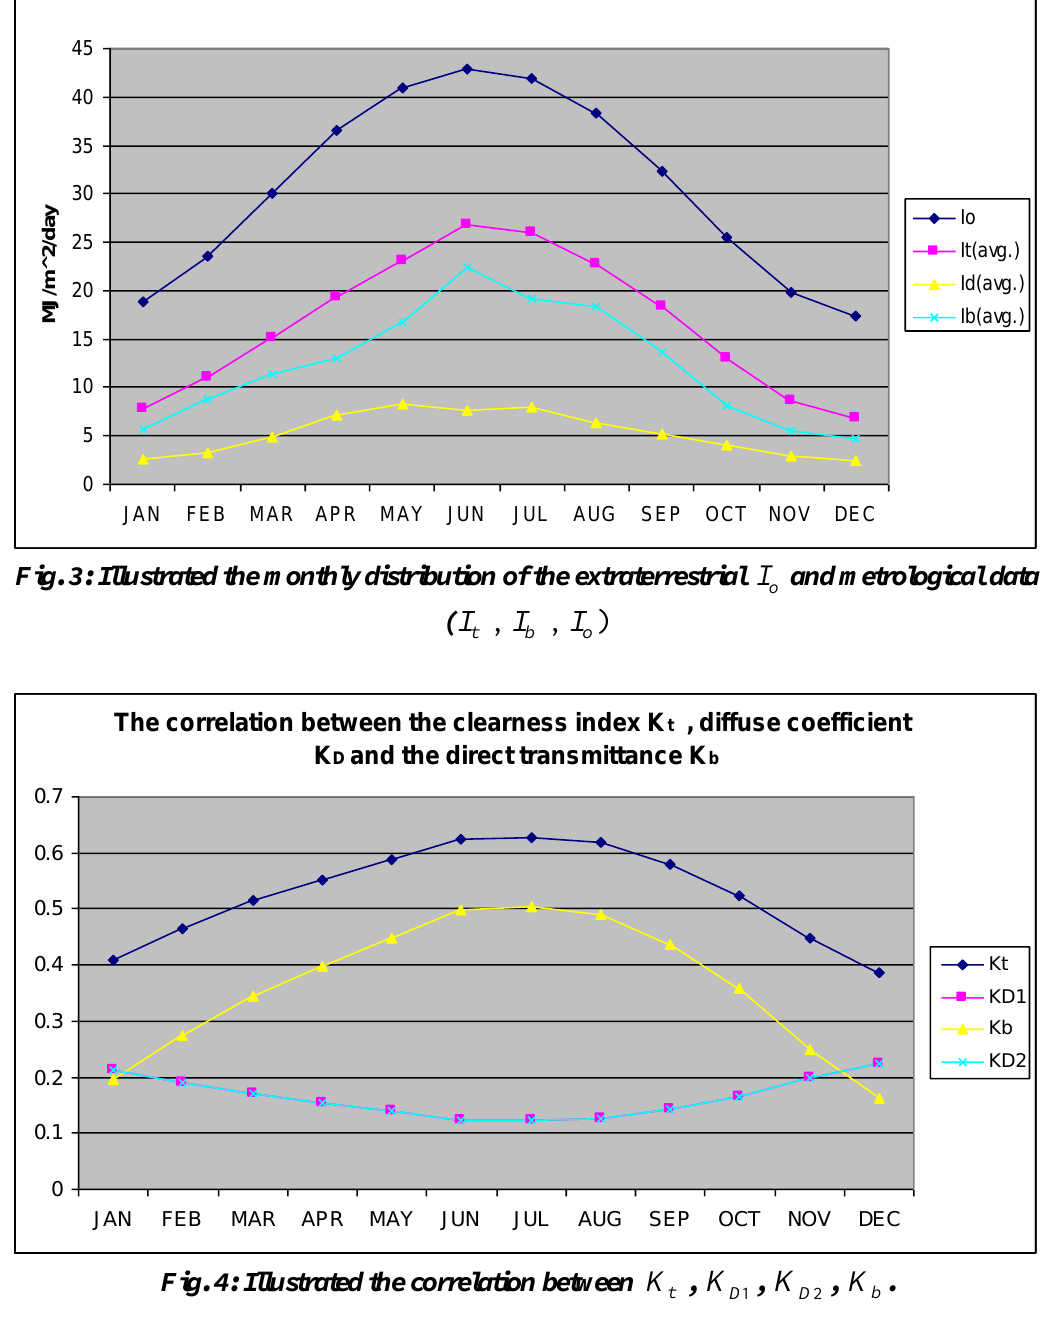
Fig. 4: Illustrated the correlation between